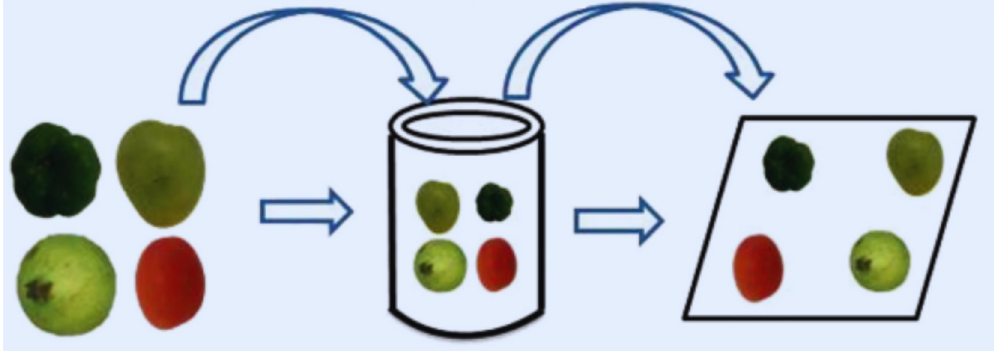
Figure 6. Dipping method for applying an edible coating. Adopted from [194] with permission.